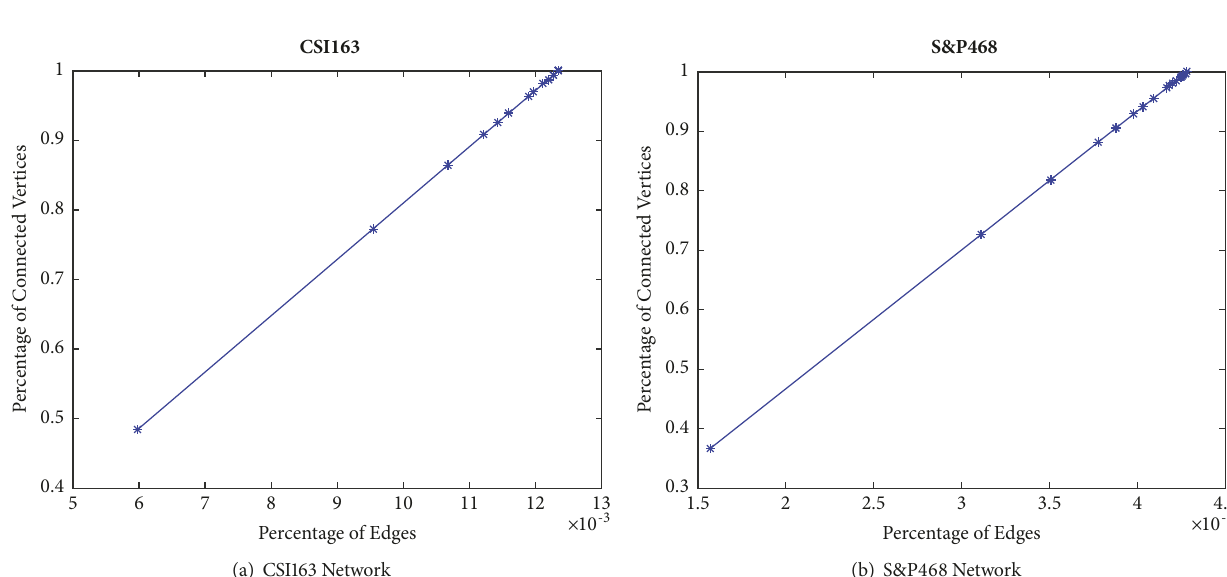
Figure 21: Percentages of connected vertices of AG against edge densities for CSI163 and S&P468